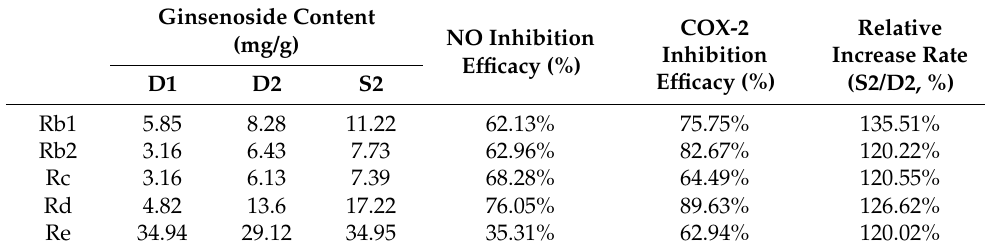
Table 2. Content and efficacy analysis of ginsenosides of P. ginseng